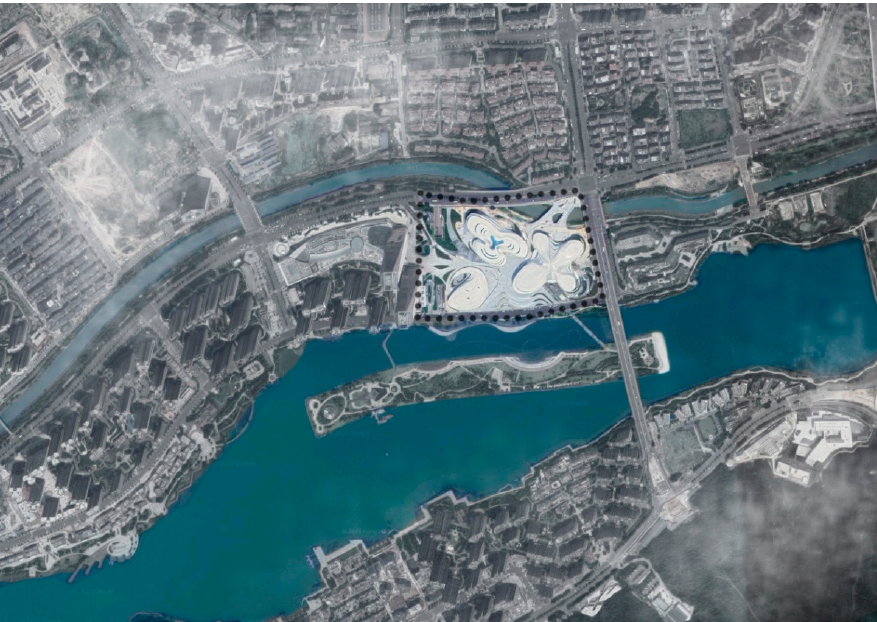
Figure 15. Location of Changsha Meixihu International Contemporary Art Museum in the city of Changsha, China, graphic processing by E. Latusek.